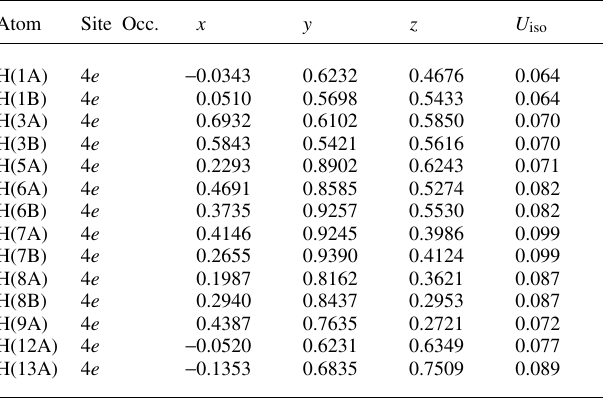
Table 2. Atomic coordinates and displacement parameters (in Å 2 )